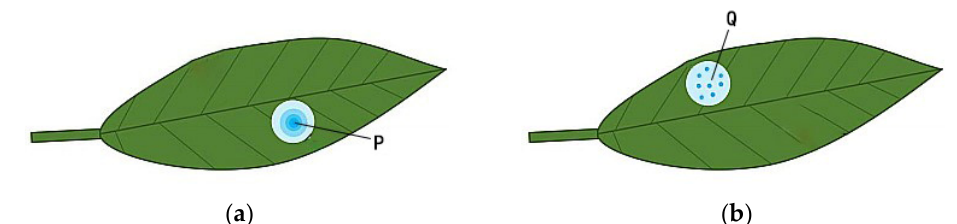
Figure 4. Schematic diagram of critical sliding droplet formation; (a) The critical sliding droplet; (b) The deposited droplet.